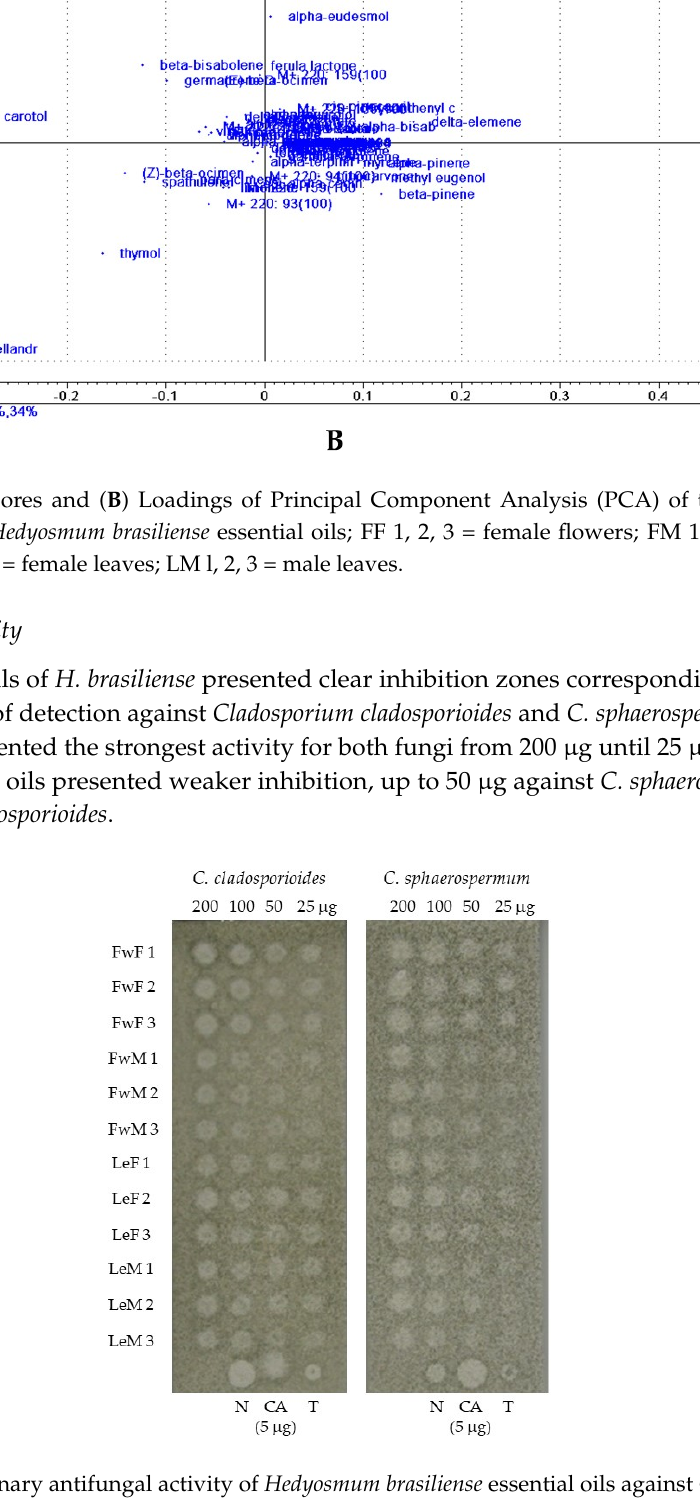
Figure 2. Preliminary antifungal activity of Hedyosmum brasiliense essential oils against Cladosporium cladosporioides and C. sphaerospermum . FwF = female flowers; FwM = male flowers; LeF = female leaves; LeM = male leaves; N = nystatin; CA = cinnamic acid; T = thymol.